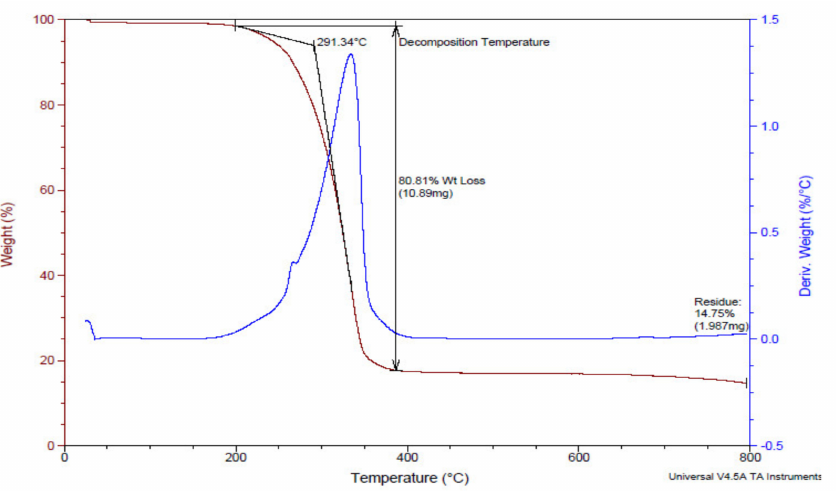
Figure 4. TGA analysis of CUR-MCT-KC bead to evaluate the change in weight at a constant heating rate of 10 ◦ C/min from 30 to 600 ◦ C. There was a sharp peak observed at approximately 320 ◦ C with 80.81% weight loss, indicating the melting phase and decomposition of CUR-MCT-KC from 200 to 350 ◦ C.